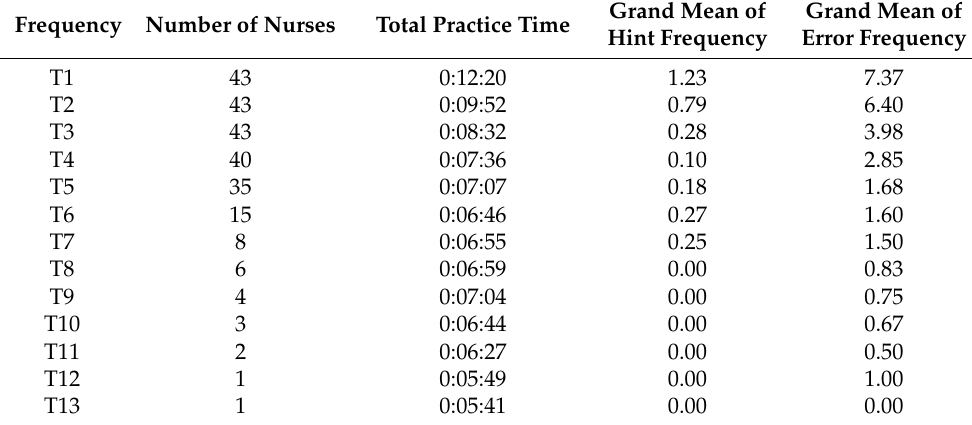
Table 6. Number of practitioners, total practice time, grand mean of level hint, and error frequency of thirteen times using virtual reality teaching materials for implanted Port-A catheter